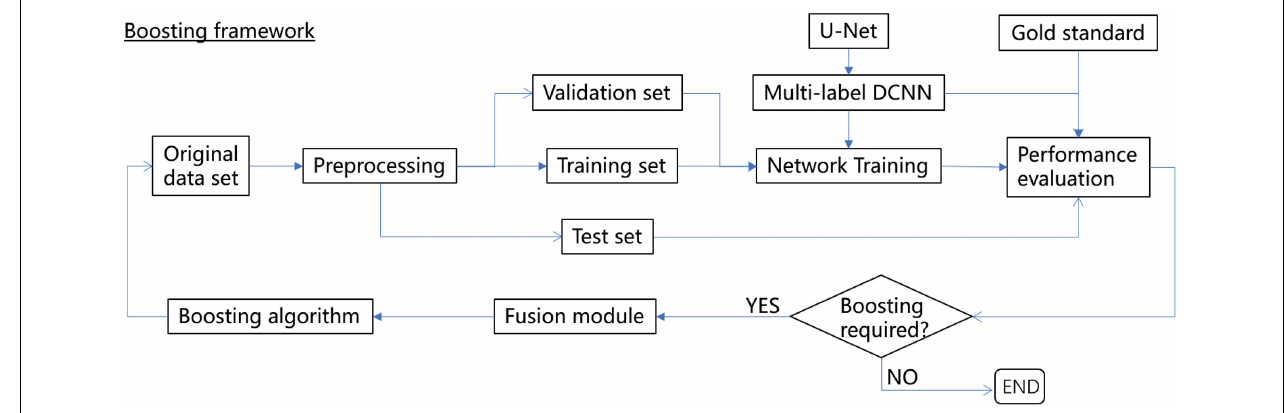
FIGURE 1 | The boosting framework for multilabel semantic